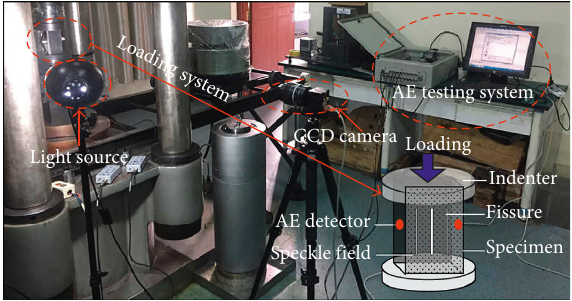
Figure 3: Experiment